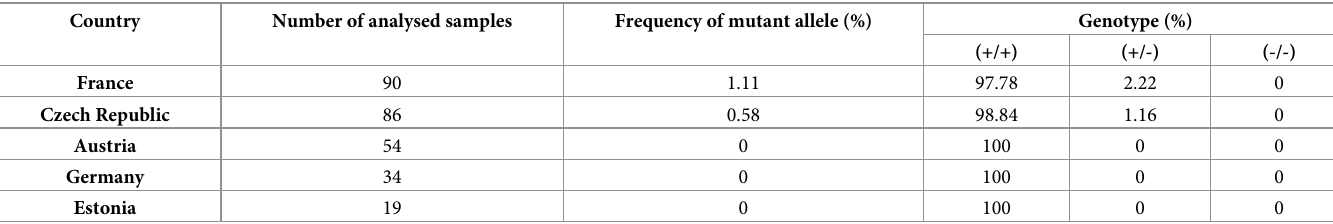
Table 4. Comparison of genotype and mutant allele frequencies in the top five countries for CMR1 disease. Country